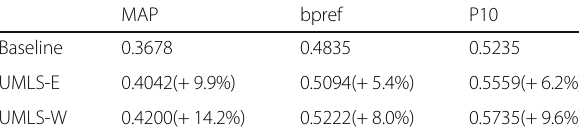
Table 3 The comparison of LGD, udelmx, and